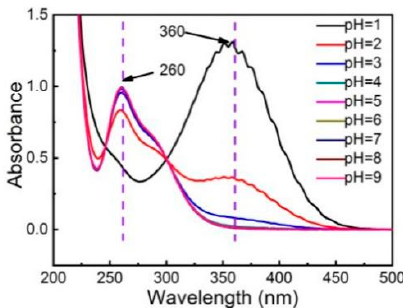
Figure 9. UV–Vis spectra of the NaClO 2 solution under different pH. Conditions: NaClO 2 concentration 0.008 mol/L; temperature 30 °C.